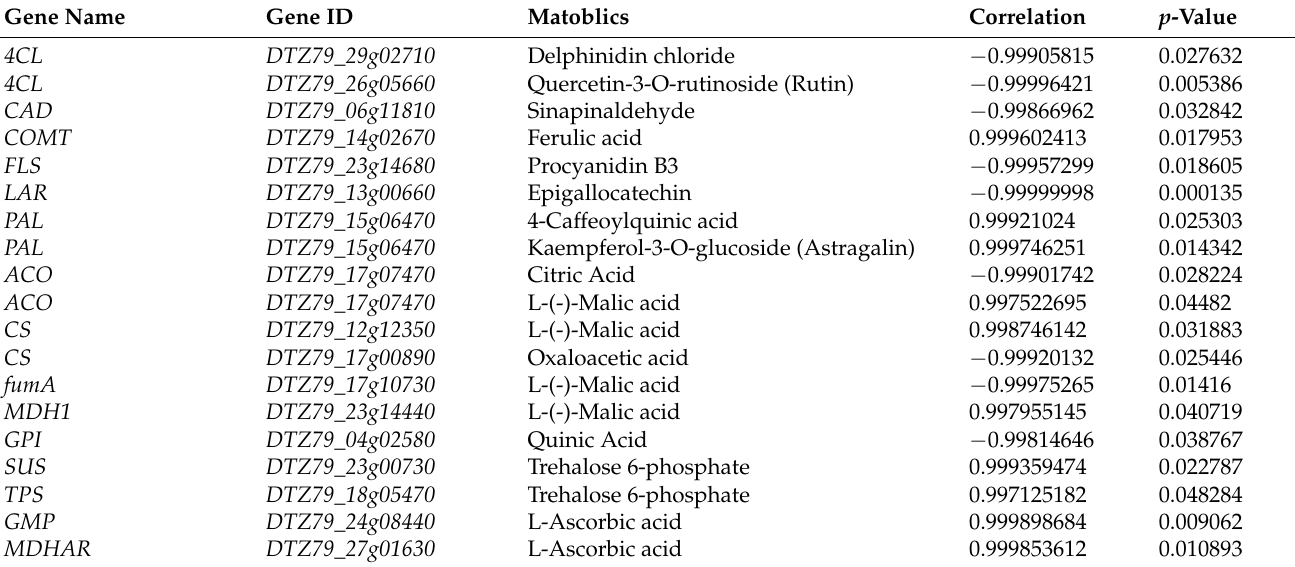
Table 3. Pearson’s correlation coefficients between gene and